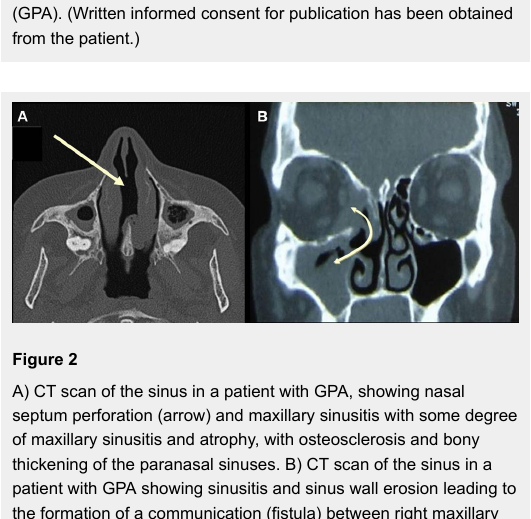
CT scan of the neck of a patient with GPA showing 6-cm-long subglottic stenosis